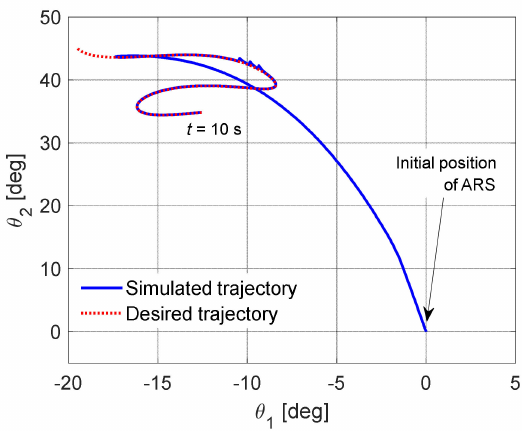
Figure 10. Simulated and desired trajectory of ARS with interference—LQR